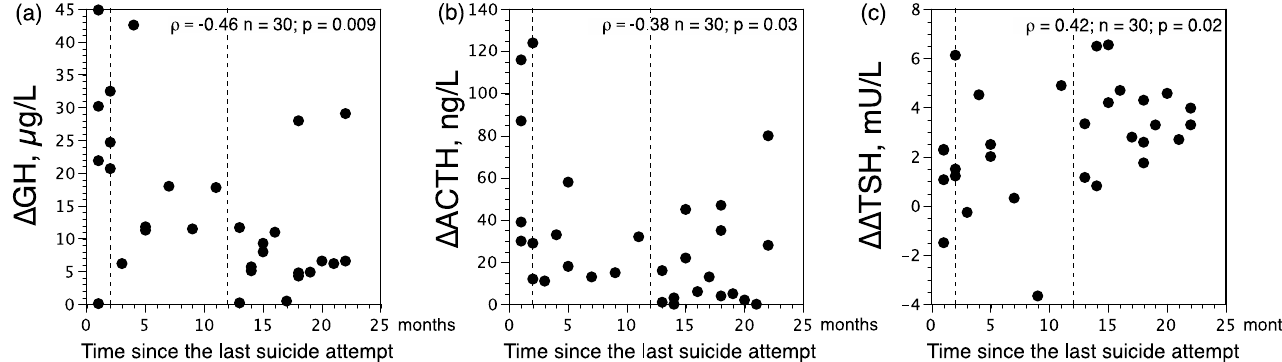
Figure 2. Scatterplots of ( a ) growth hormone ( ∆ GH) and ( b ) adrenocorticotropic hormone ( ∆ ACTH) responses to apomorphine (0.75 mg SC), and ( c ) difference between 11 PM and 8 AM maximum increments in thyrotropin ( ∆∆ TSH) after 200 µg of protirelin given intravenously, against the time elapsed since the last suicide attempt (in months) in major depressed patients with suicidal behavior disorder (SBD). Values are plotted individually; p values derive from Spearman’s rank correlation analyses ( ρ ).